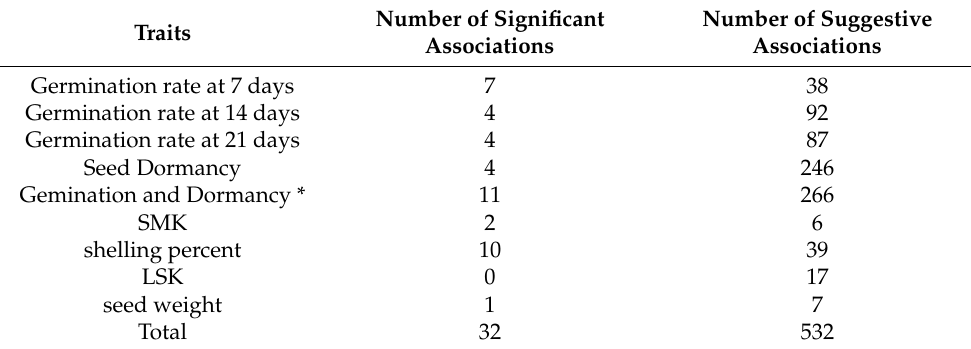
Table 3. Summary of the number of associated SNP for seed germination, dormancy, and seed grading.